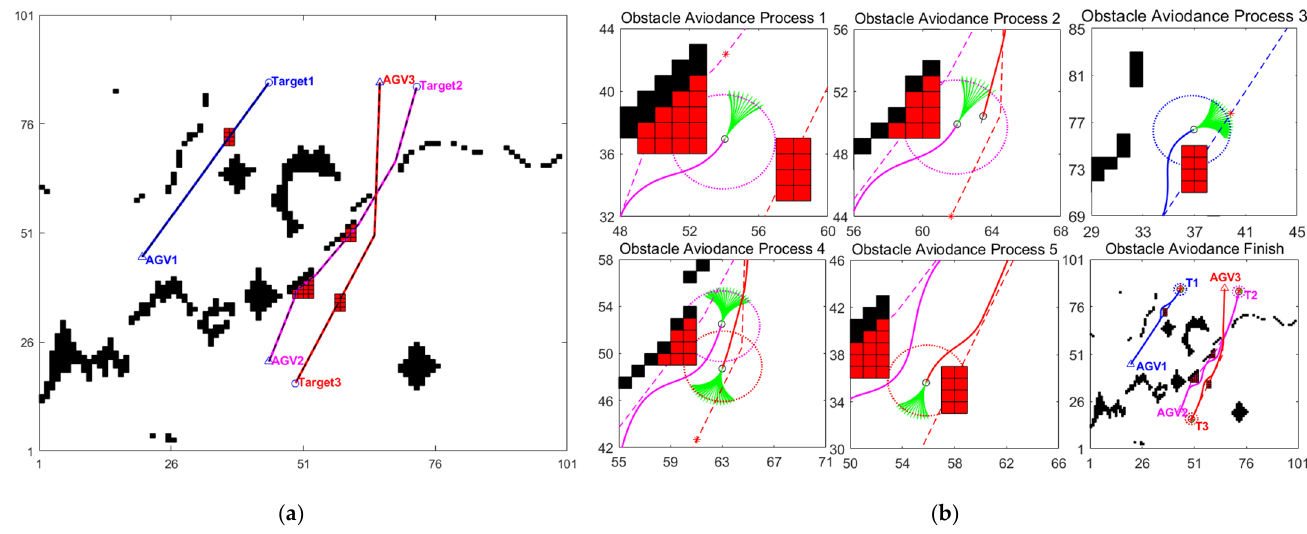
Figure 25. Multi-robot path planning 3. ( a ) Global path planning. ( b ) Robot local motion.